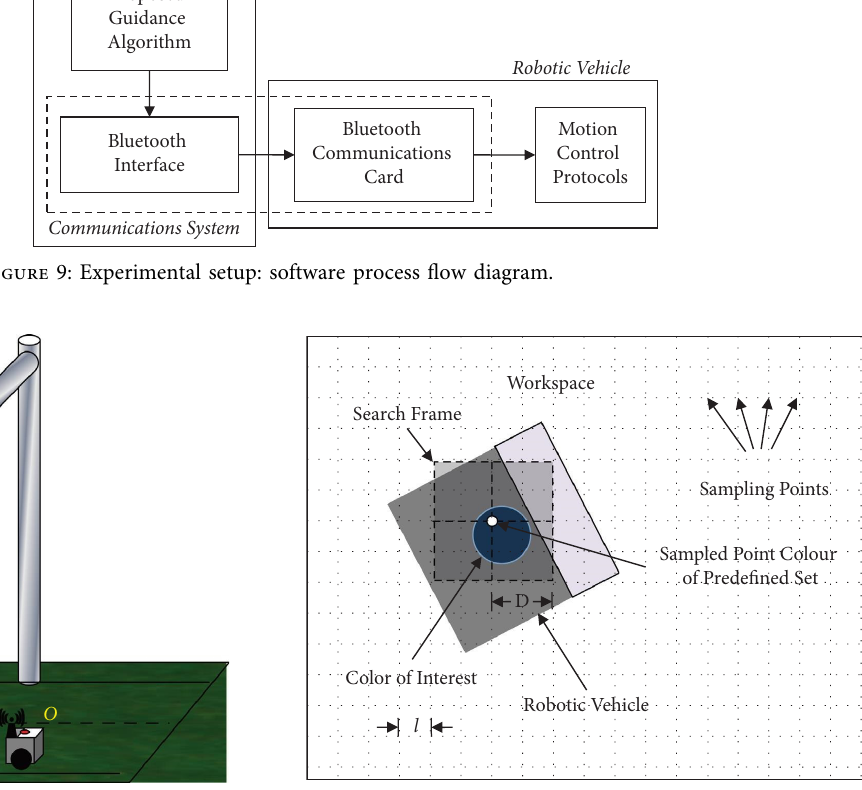
Figure 10: Experimental setup: physical layout. Figure 11: Searching for color